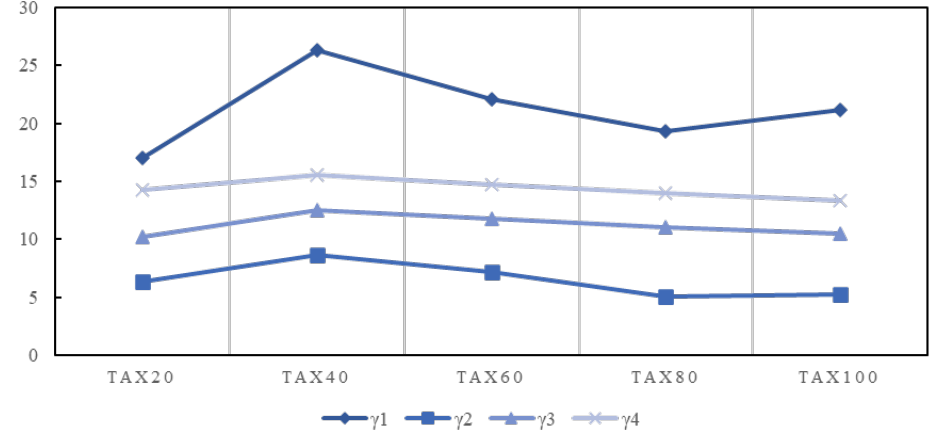
Figure 5. Changing trend of macroeconomic elasticity value of carbon emissions reduction.